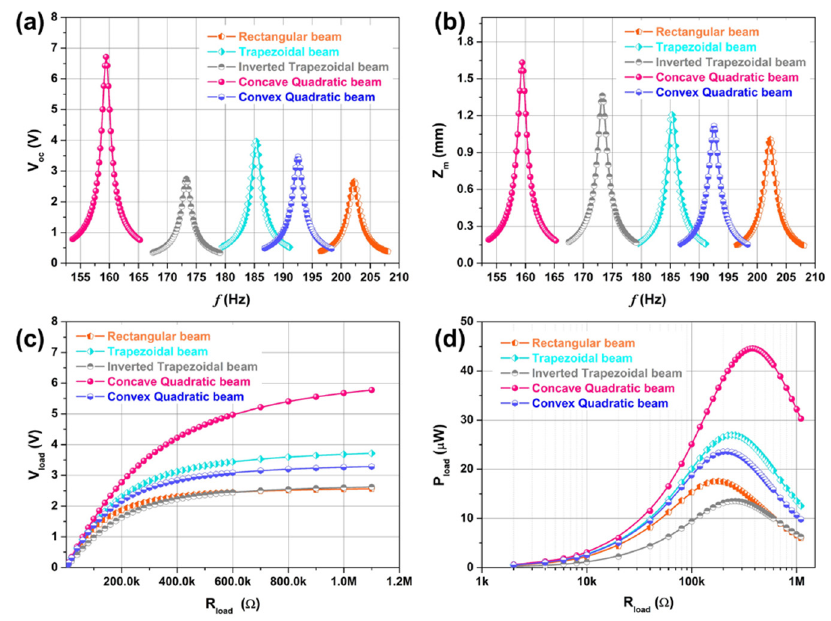
Figure 3. Output performance of five MEMS variable cross-section cantilever beam based piezoelectric vibration energy harvesters with different cross-sectional shapes. ( a ) frequency response curve of open-circuit voltage, ( b ) frequency response curve of the maximum displacement of the tip mass, ( c ) load characteristic curve of output voltage, and ( d ) load characteristic curve of output power. These cases show results for an external excitation acceleration of 1 g.